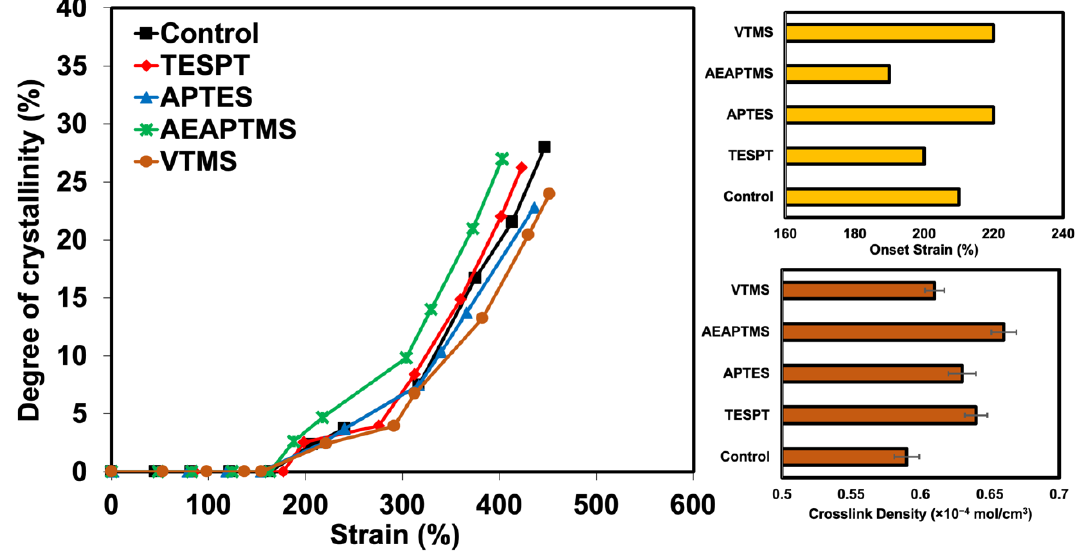
Figure 13. Degree of crystallinity as a function of applied strains together with onset strains and corresponding crosslink density of NR/HNT composites filled with and without silane coupling agents.